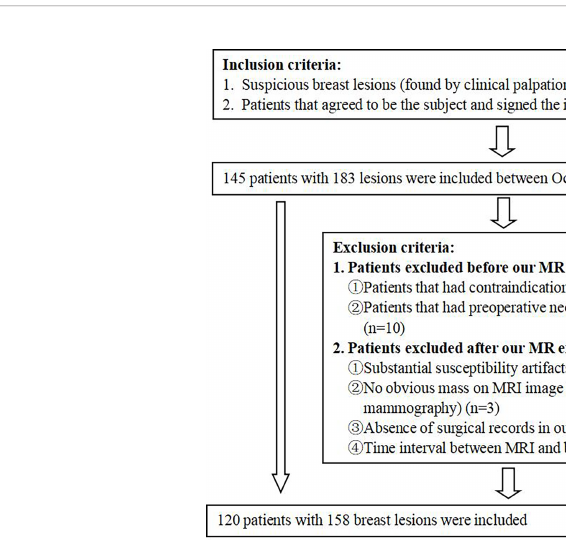
Figure 1 . Twenty-two patients had two or more neoplasms, and